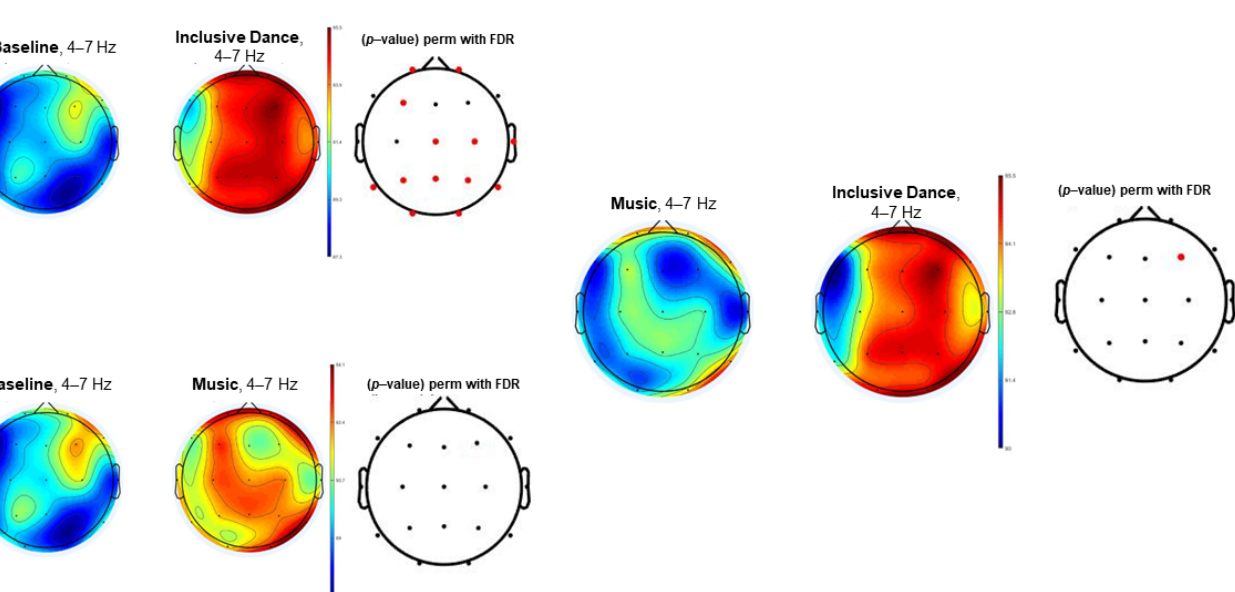
Figure 2 . EEG topographic maps in the alpha power spectrum (8–12 Hz) of the comparison between baseline, inclusive dance, and listening to music conditions. Significant comparisons ( p ‐ value < 0.05) have been highlighted in red.